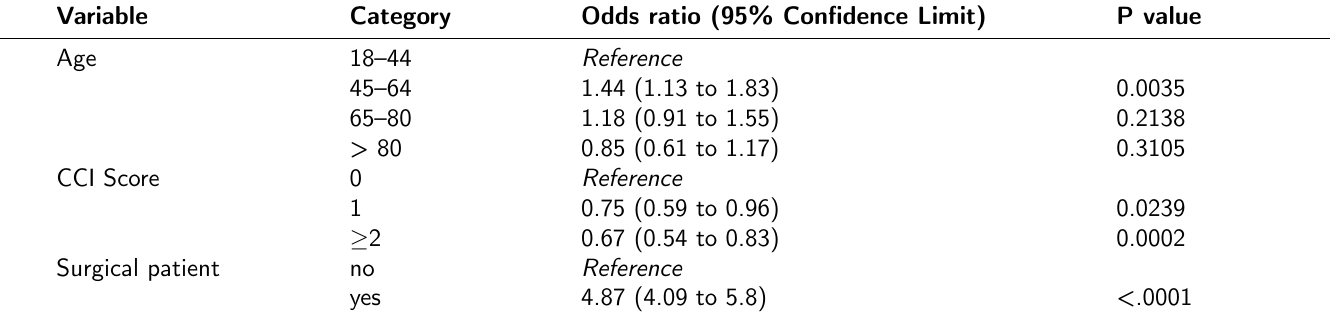
Table 3: Variables associated with missing discharge summaries in the EMR by multivariable logistic regression* Variable